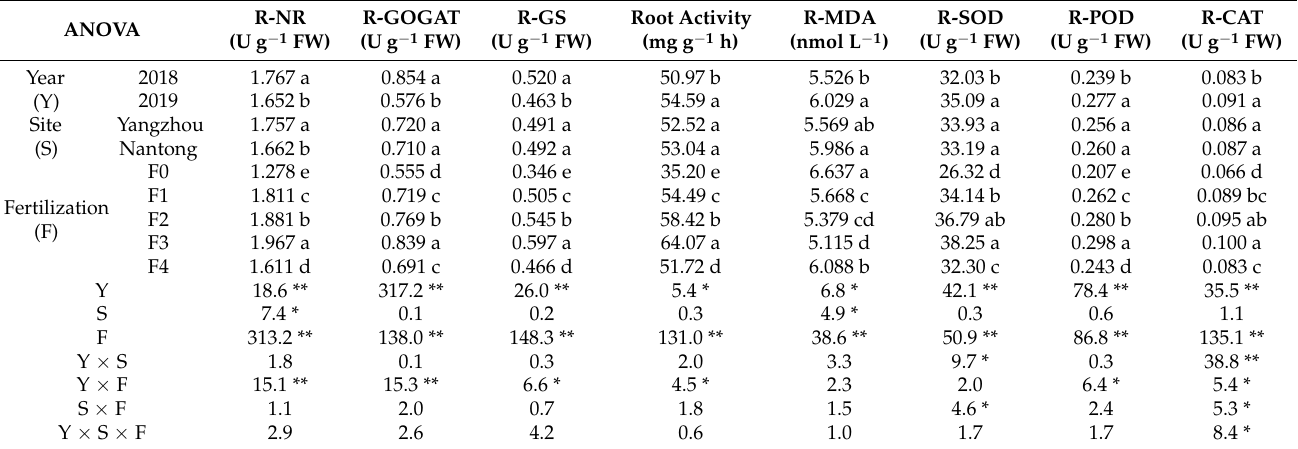
Table 2. Analysis of variance for optimized fertilization practices on root activity and the activities of N metabolism enzymes and antioxidant enzymes in root of fresh waxy maize.